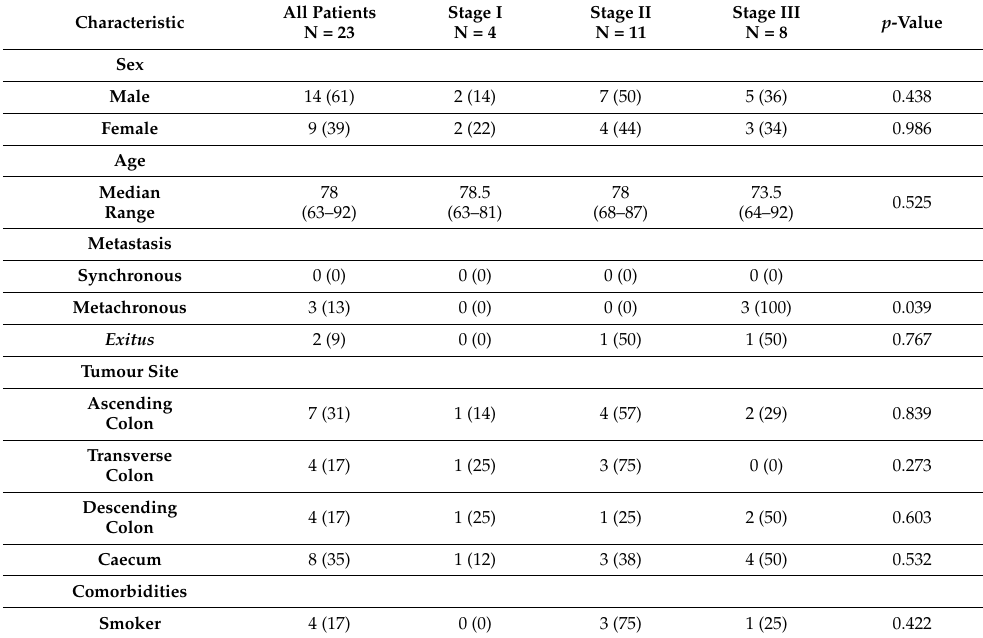
Table 1. Retrospective Patient’s Cohort Characteristics 1